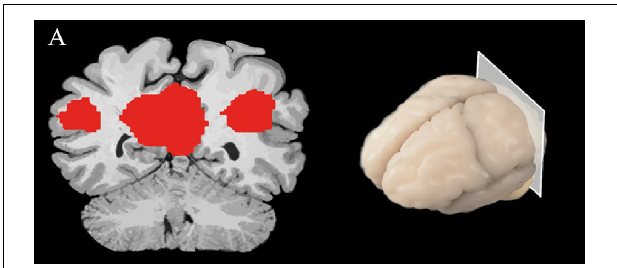
FIGURE 2 | A spatial map of a brain slice is represented, demonstrating brain activity in the DMN; red represents regions that are most active while the individual is at